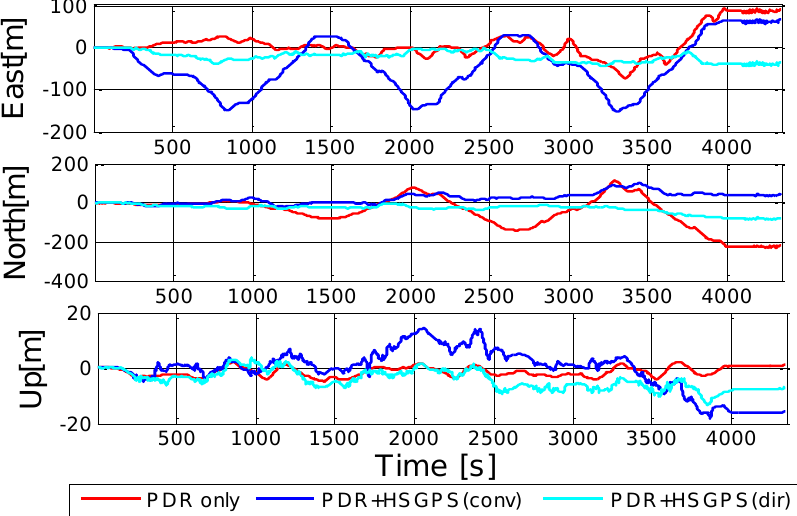
Figure 11. Position errors of various navigation